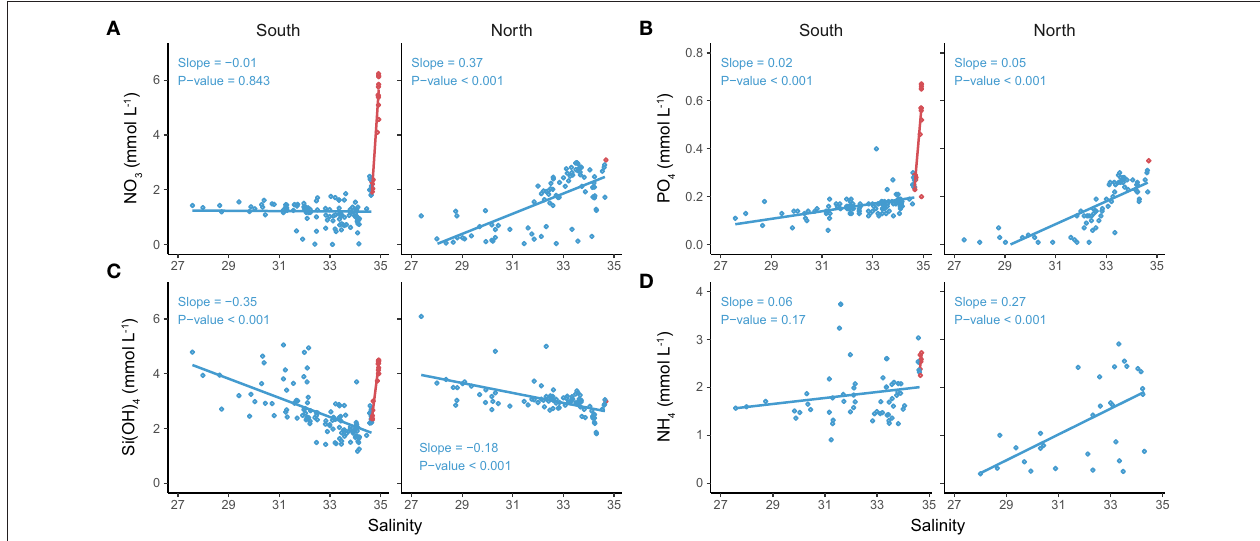
FIGURE 8 | Relationship between nutrient concentrations and salinities for surface (blue) and Atlantic waters (red), classified according to Cottier et al. (2005), in the Southern and Northern Glacier Zones. (A) nitrate and phosphate, (B) silicic acid and ammonium. Slopes and their p -values for surface waters are in blue font.